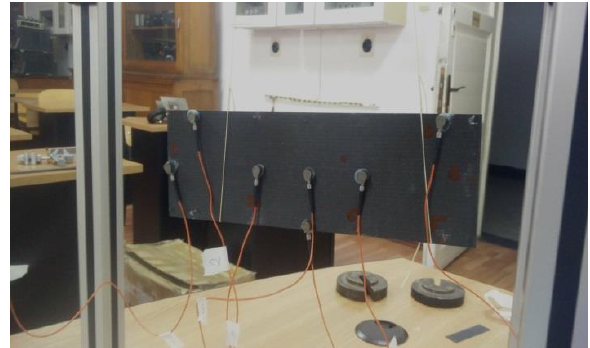
Fig. 6 Instrumentation of the 0° laminated plate for OMA The plates were suspended on elastic strings for free-free boundary conditions and the response to random taps was captured by accelerometers. The data was processed with the OMA module of the ARTEMIS software, separating the noise and inputs from the outputs and returning the unbiased modal information only.